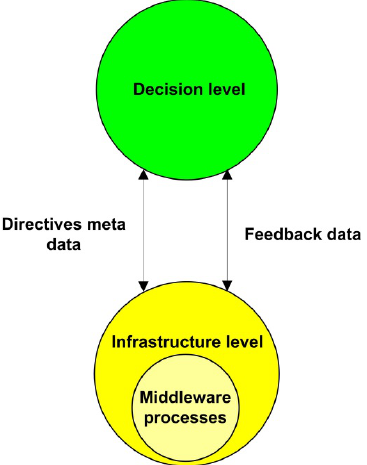
Figure 9. Self-Organizing Smart Grid Services components, as described in